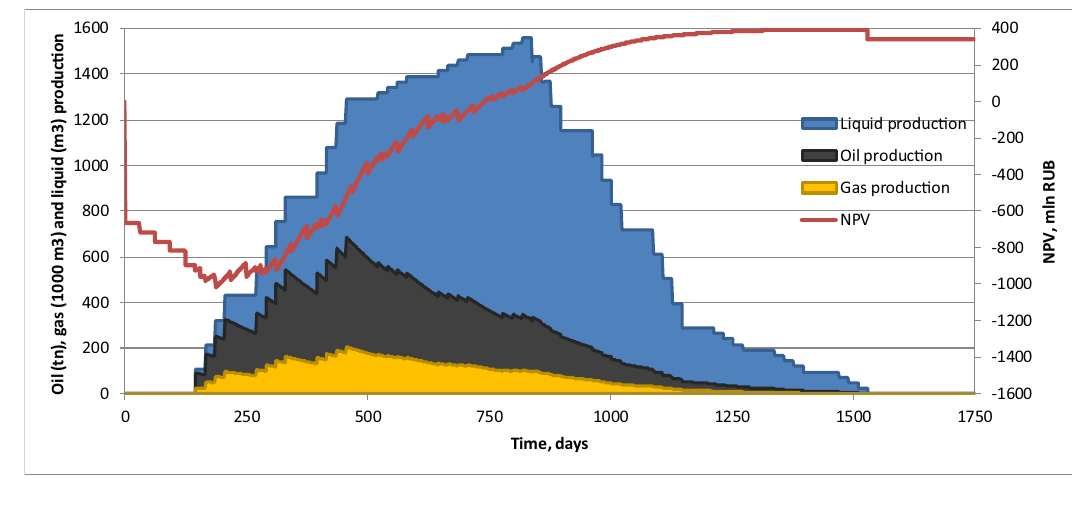
Fig. 5 Scenario 1 reference design well pad production and NPV profiles